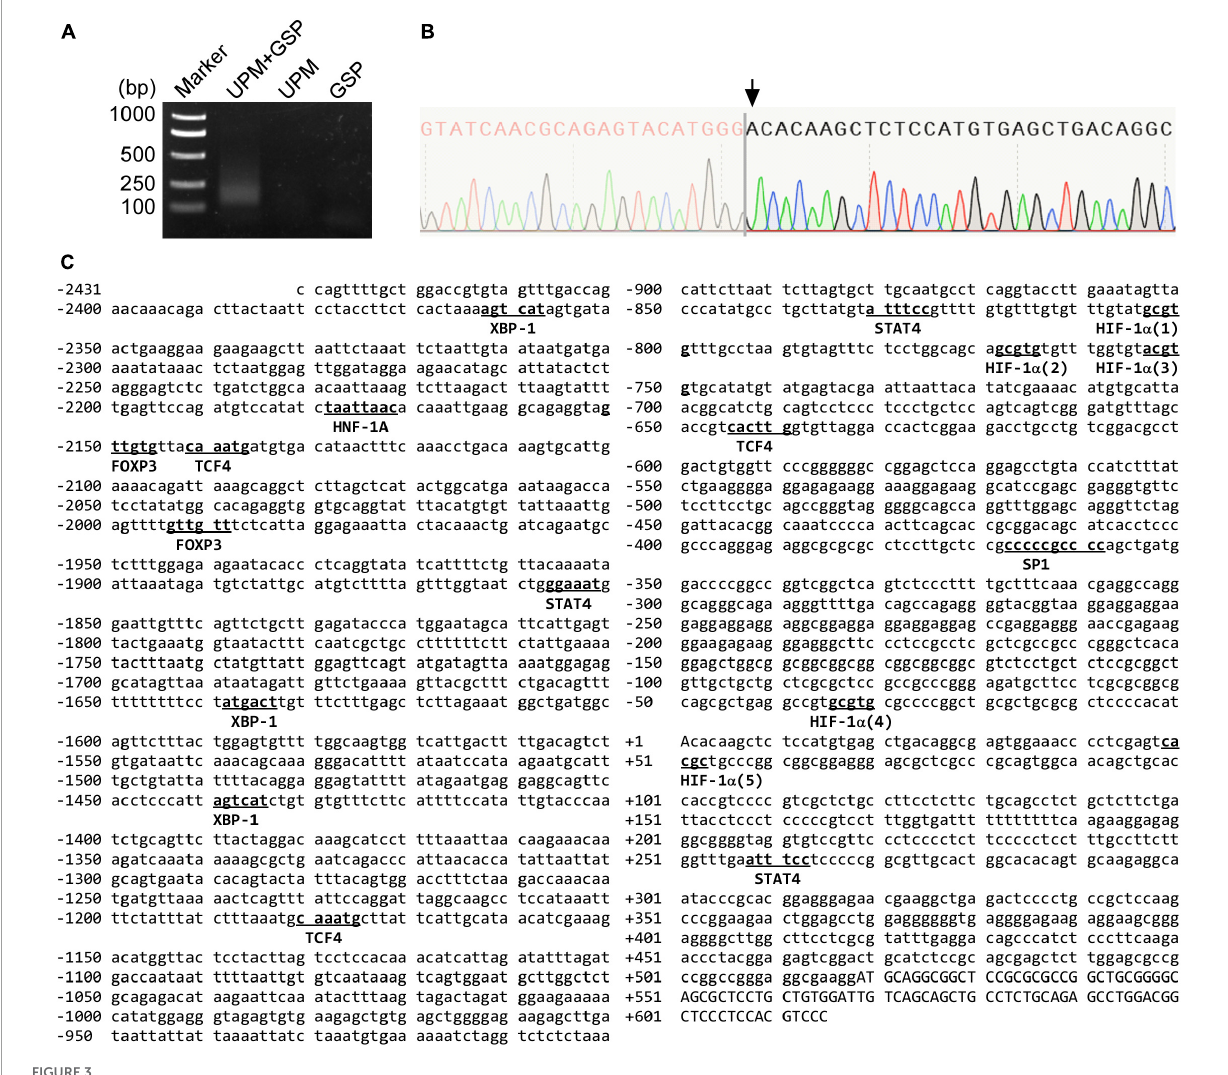
FIGURE3 The sequence map of the human CNTNAP2 gene promoter. (A) 5 (cid:48) -RACE assay was conducted to map the CNTNAP2 transcription start site (TSS). The PCR product was analyzed on a 2% agarose gel. USP = universal primer, GSP = CNTNAP2 gene specific primer. (B) The 5 (cid:48) -RACE PCR product was cloned into the pRACE vector and sequenced to identify the TSS. The TSS is the first nucleotide after the SMARTer oligonucleotide, as indicated by the arrow. (C) The sequence of the human CNTNAP2 gene promoter. A 2,868 bp 5 (cid:48) -flanking region of the human CNTNAP2 gene was amplified from HEK genomic DNA. The TSS Adenine is designated +1. The putative binding sites for computationally predicted transcription factors are